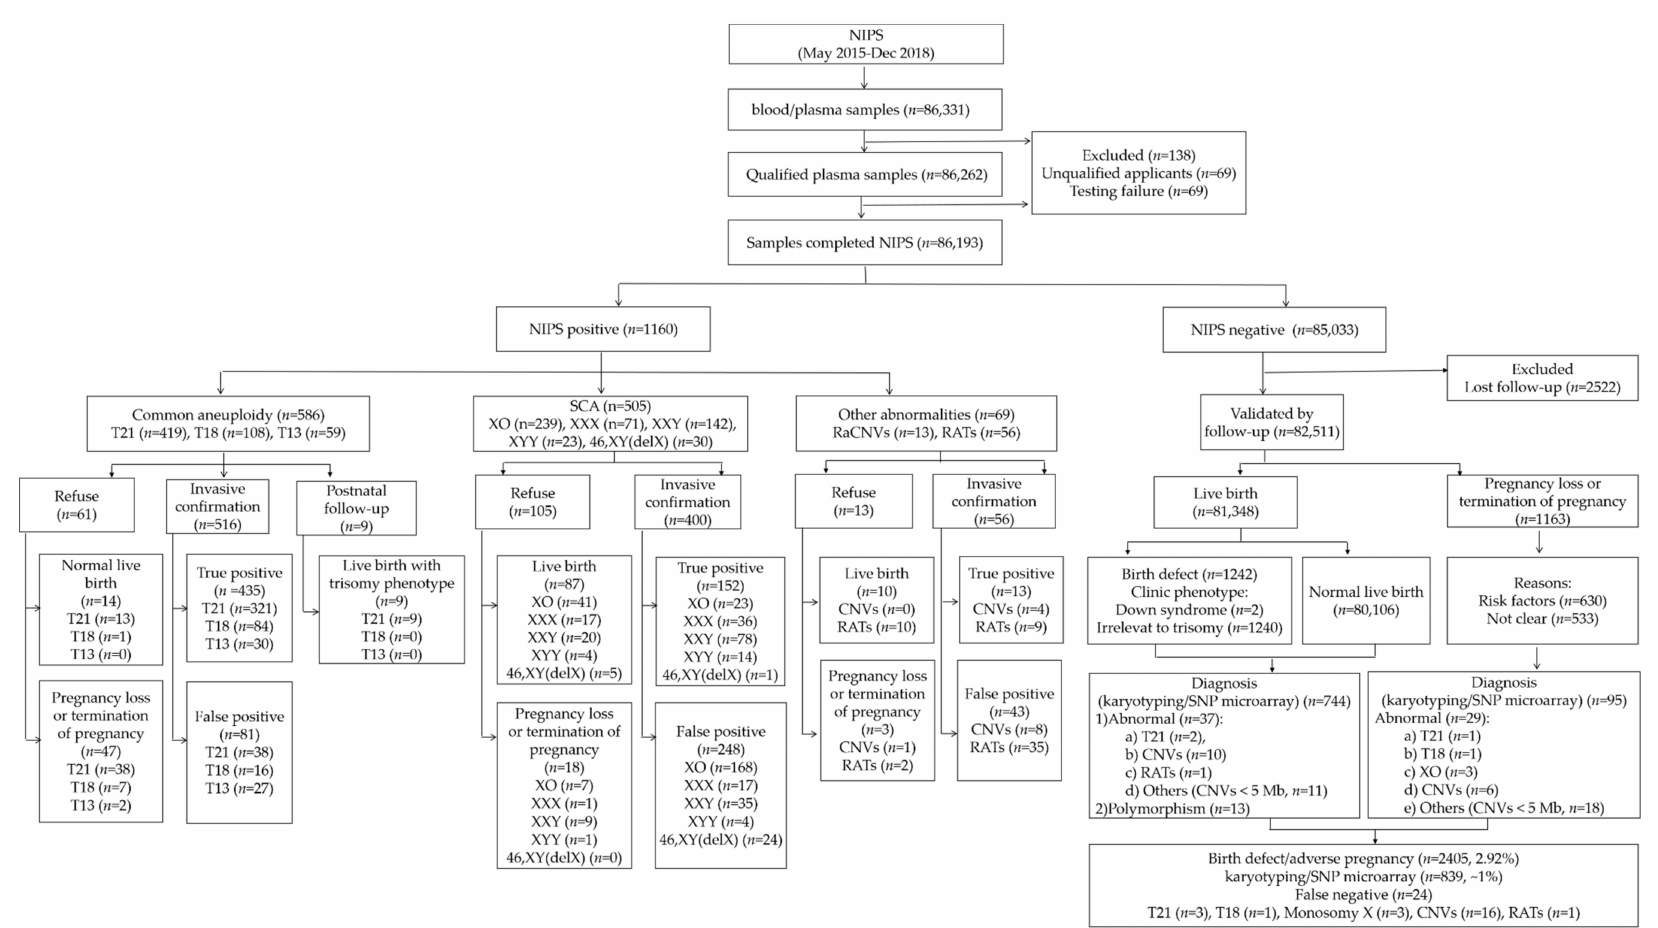
Figure 1. Flowchart of noninvasive prenatal screening (NIPS) and outcomes of singleton pregnancies in a single